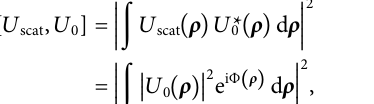
algorithm performance for two-photon excited fl uorescence (TPEF) imaging of a homogeneous “ dye-slide ” sample in different regimes of turbidity ( Section 4.4 ) as well as mouse brain ( Section 4.5 ). In Section 4.6 , implications of a low SNR on algorithm performance are